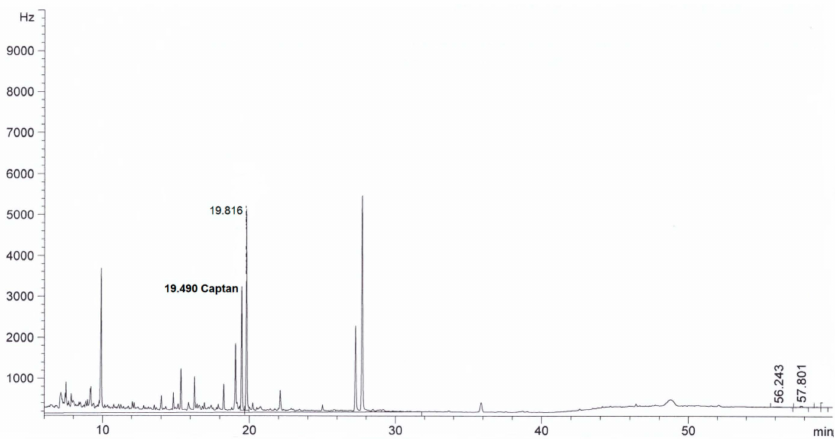
Figure 3. The chromatogram (GC- µ ECD) of industrial wastewater with the clean-up step using the dSPE (1 g Al 2 O 3